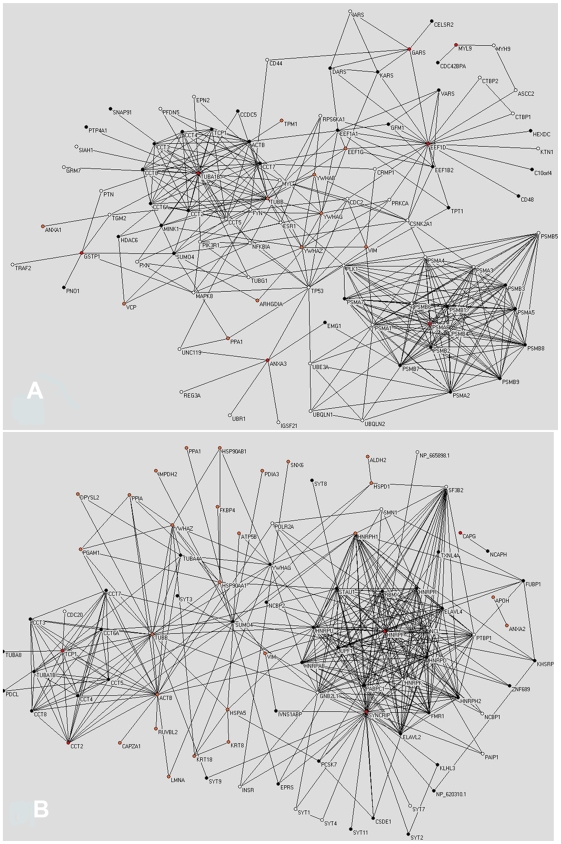
Significant sub-networks induced by proteomic seeds.Network graph visualization of sub-networks induced by Friedman seed, scored using GSE10950 (a) and Nibbe seed, scored using GSE8671 (b). Proteomic seeds that induced a significant crosstalker sub-network are shown in red, other proteomic seeds are shown in orange, crosstalkers are black and interactors are white. Visualization was performed with the Pajek software.